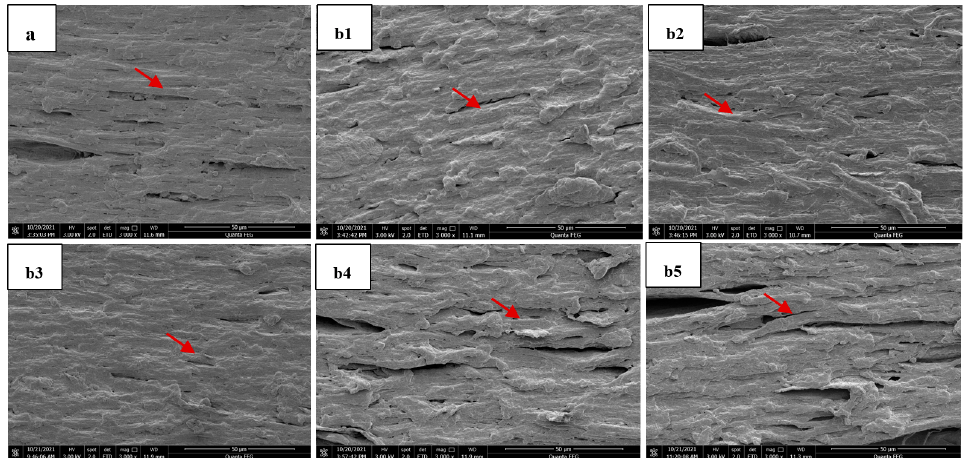
Figure 1. Effect of cysteine content on the microscopic morphological images of the extrudates.